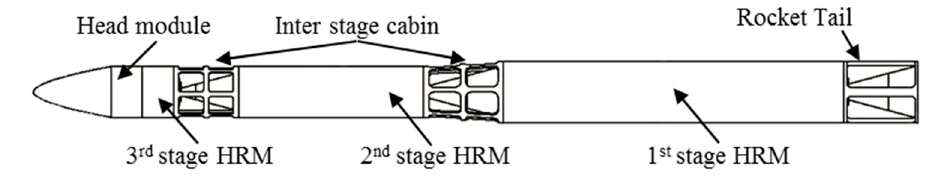
Figure 6. Typical HRM-powered LV configuration.